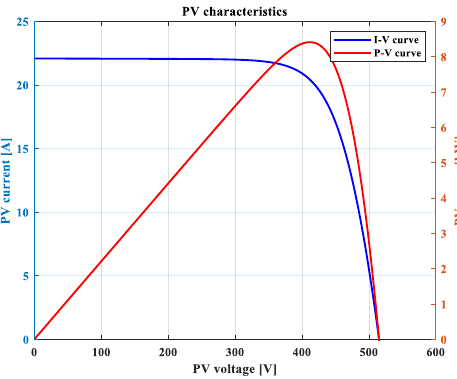
Figure 4. Current–voltage (I–V) and power–voltage (P–V) curves at Standard Test Conditions Figure 4. Current – voltage (I – V) and power – voltage (P – V) curves at Standard Test Conditions (STC).